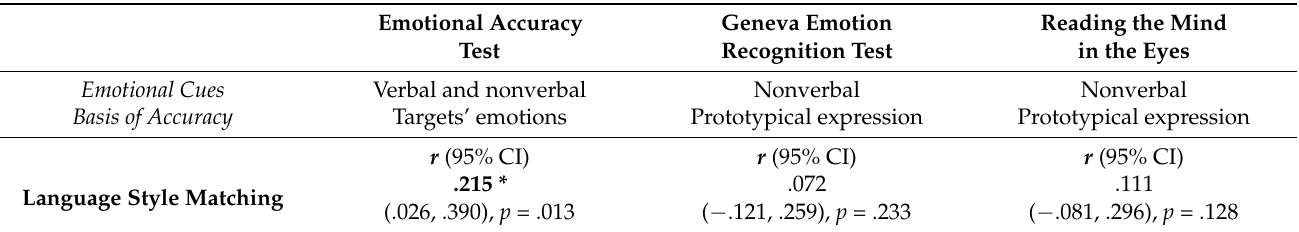
Table 1. Description of the three recognition tests and Pearson correlation coefficients for their associations with language matching style (N =